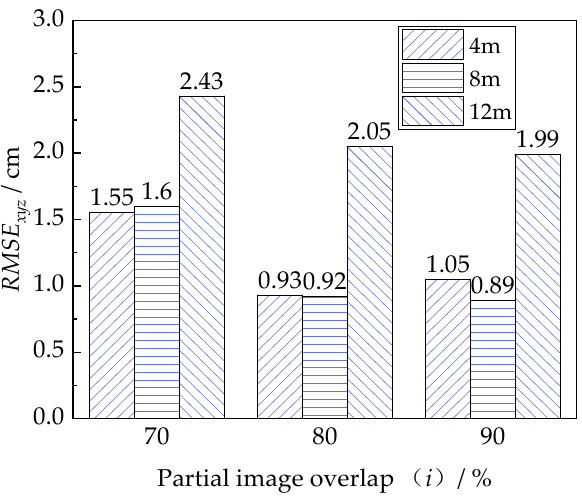
Figure 8. The effect of the partial route on the quality of the 3D beam model.